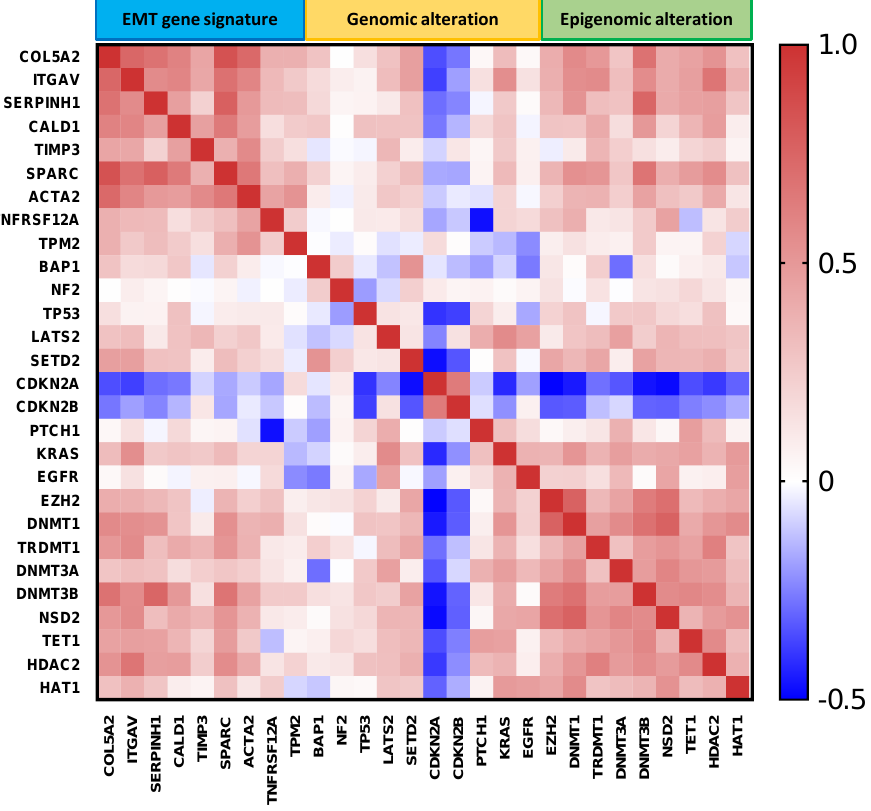
Figure 5. MESO EMT gene expression correlated with genomic/epigenomic alterations. Red and blue colors represent positive and negative correlation, respectively. The bar on the right represents the p values of